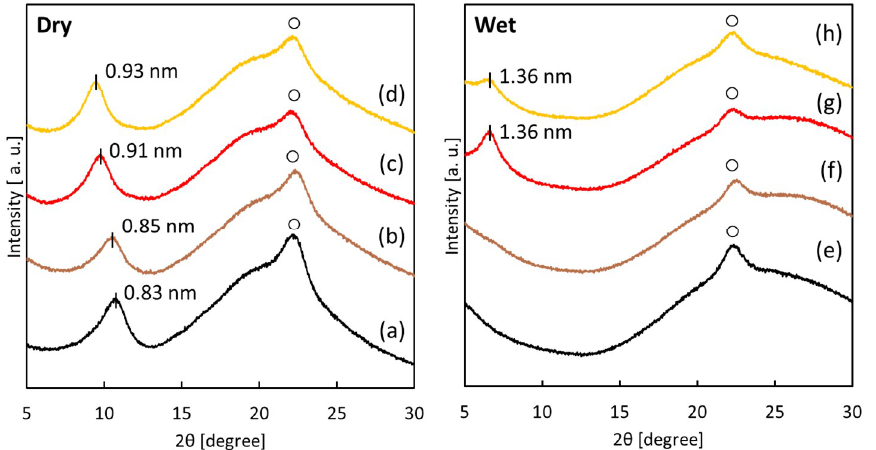
Figure 3. X-ray diffraction (XRD) patterns of the unmodified GO membranes ( a ) and ( e ) and GO-TEOA membranes fabricated with TEOA/GO = 0.5 ( b ) and ( f ); 1 ( c ) and ( g ) and 2 ( d ) and ( h ) in dry and wet conditions. Note that “◦” represents the cellulose nitrate support.